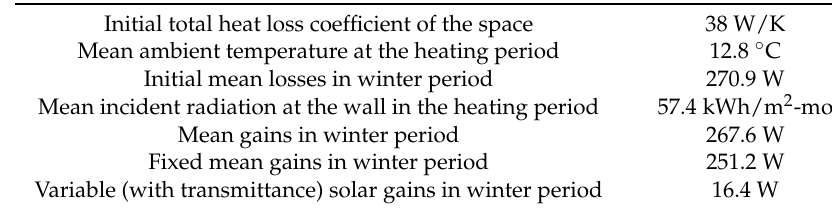
Table 5. Calculated quantities in the demonstrative